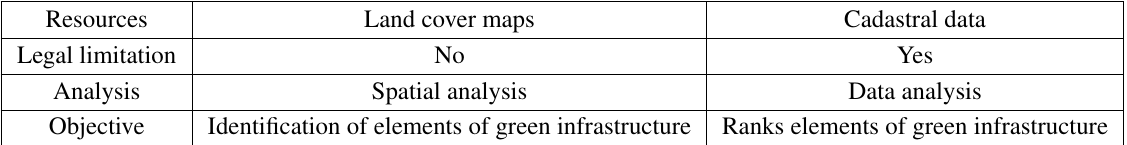
Table 1. Differences between land cover maps and cadastral data